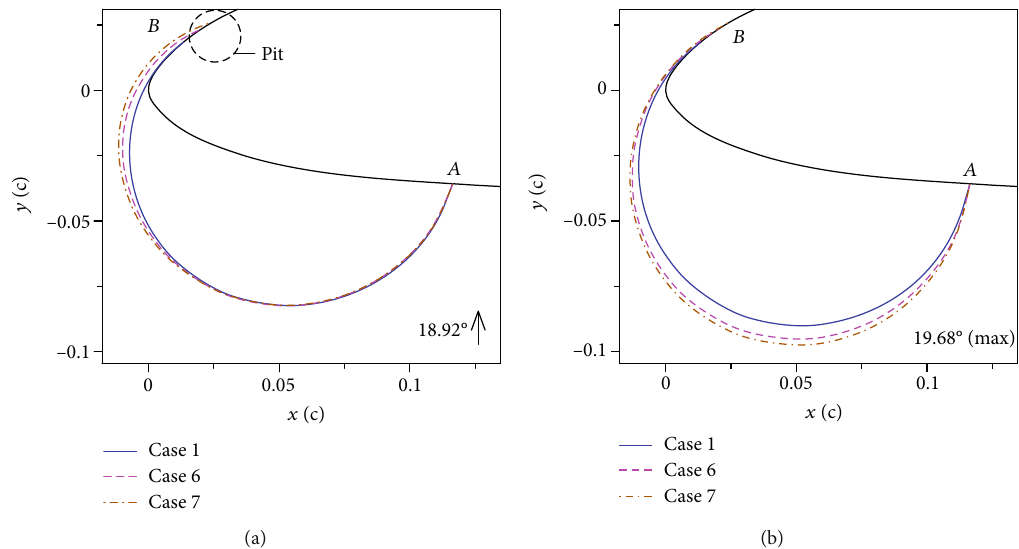
Figure 29: Comparison of the ILE shapes at angles of attack of 18.92deg upstroke and 19.68 deg in airfoil frame of reference for Cases 1, 6, and